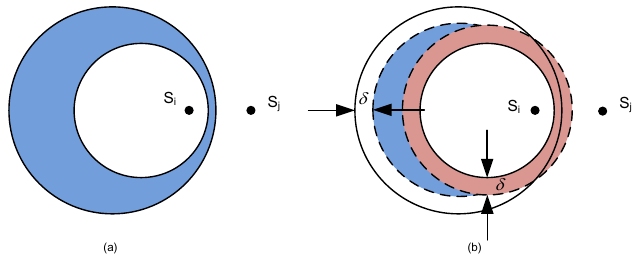
Figure 6. The location margin of δ . The blue region shows the location of GW: with location margin ( b ); and without location margin ( a